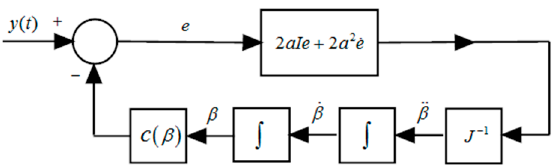
Figure 8. Control scheme for the kinematic inversion.